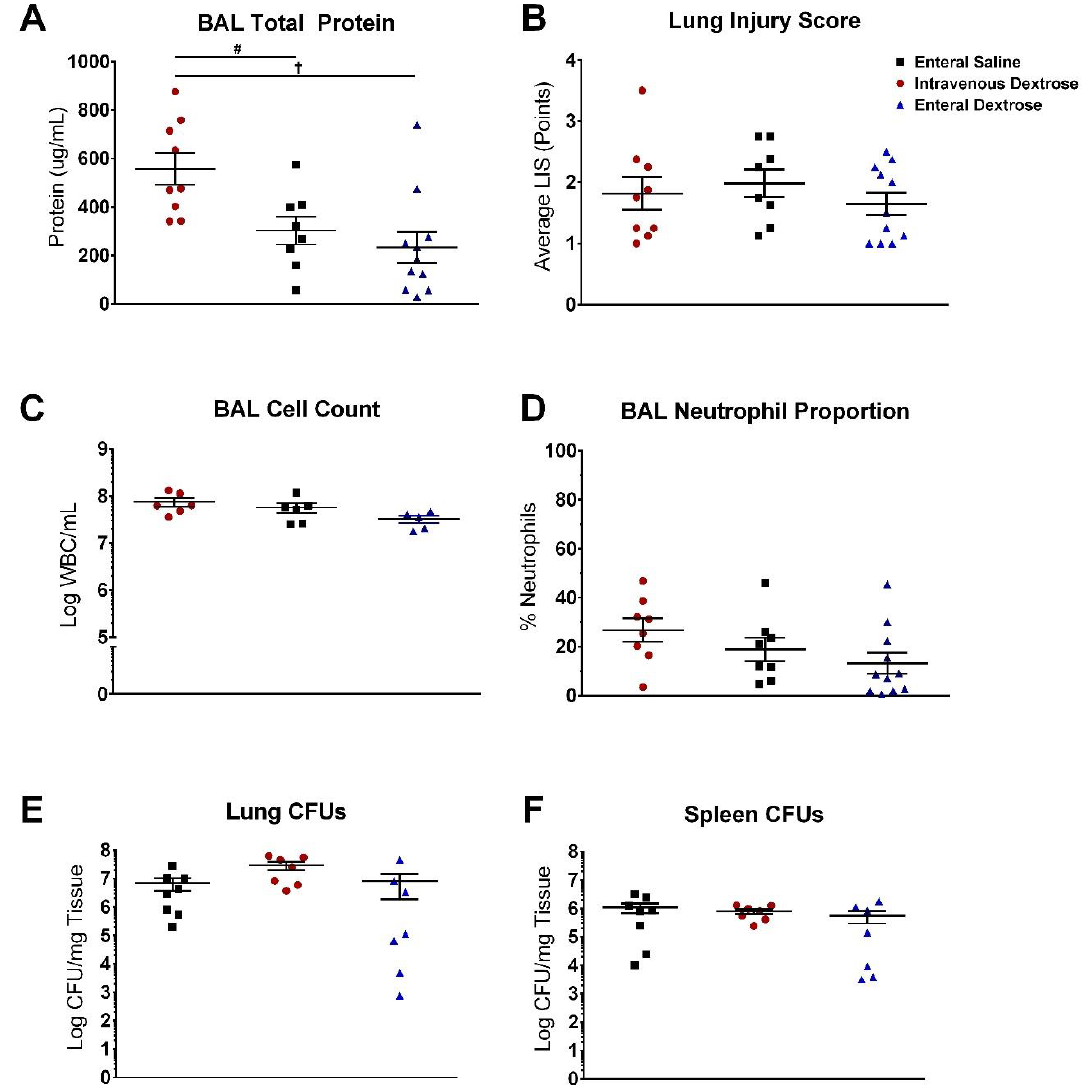
Figure 5. IV dextrose increases lung permeability in a KP model without increases in bacterial burden. ( A ) Bronchoalveolar lavage (BAL) protein concentration measured from BAL supernatant. ( B ) Histological assessment of hematoxylin and eosin-stained sections of the right lung. ( C ) Total BAL cell counts. ( D ) Proportion of neutrophils in BAL supernatant. ( E ) Colony forming units (CFUs) from whole left lung homogenate. ( F ) CFUs from splenic homogenate. # = p < 0.05 for comparison between IV dextrose and enteral saline groups. † = p < 0.05 for comparison between IV dextrose and enteral dextrose groups by one-way ANOVA with Tukey’s multiple-comparison tests. Abbreviations: BAL, bronchoalveolar lavage. LIS: lung injury score. WBC: white blood cell.